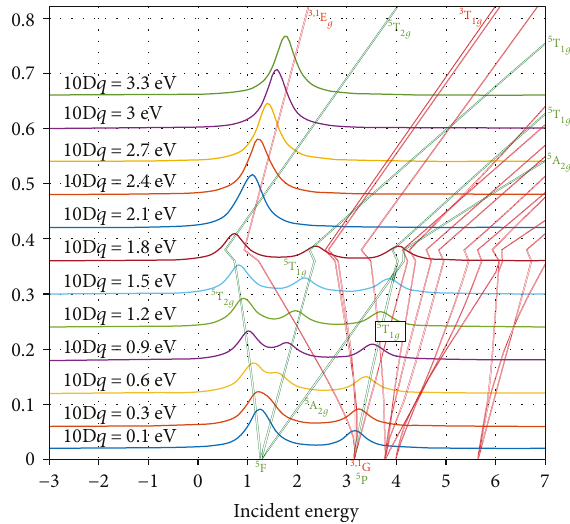
Figure 45: 1s XASprojections of the calculated 1s2p RIXSspectrum for Fe 2+ ( 3d 6 ) showing the high spin to low spin transition just above 10D q ≈ 1 8eV